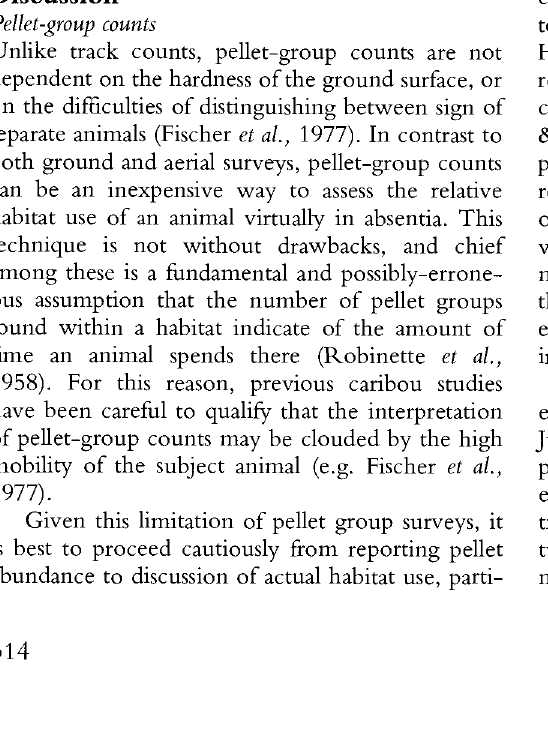
groups are subdivided based on morphology into coalesced pellet-groups (a), transitional pellet-groups (b), and scattered pellet- groups (c). Standard devi ation is less than 50% of the mean value for habi tat-types